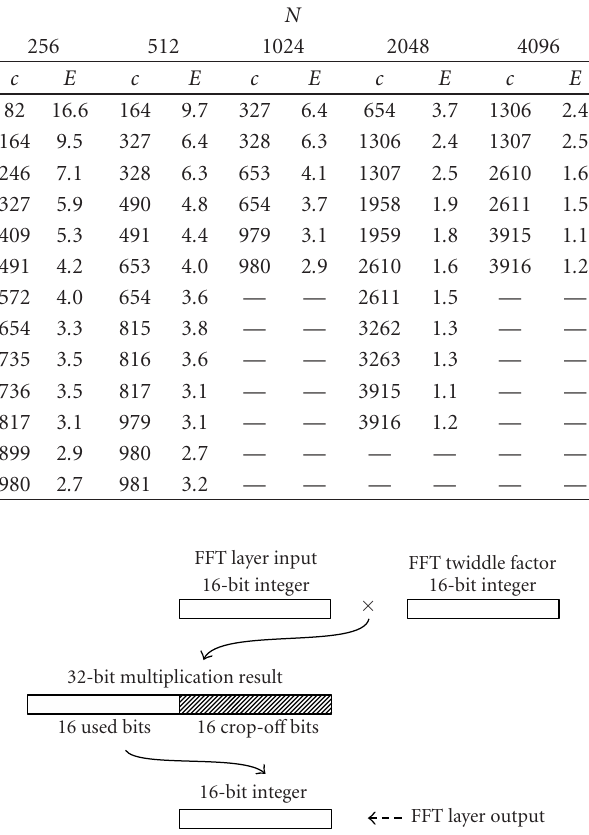
Figure 3: Multiplication of a 16-bit integer, followed by a bit shift in a layer of the ff tgen